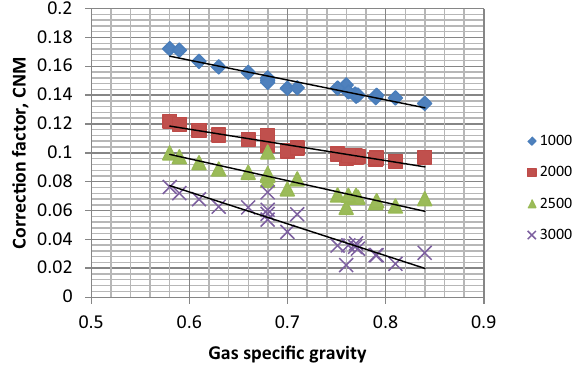
Fig. 9 Calculation of C NM at 260 (cid:3) F and different pressures